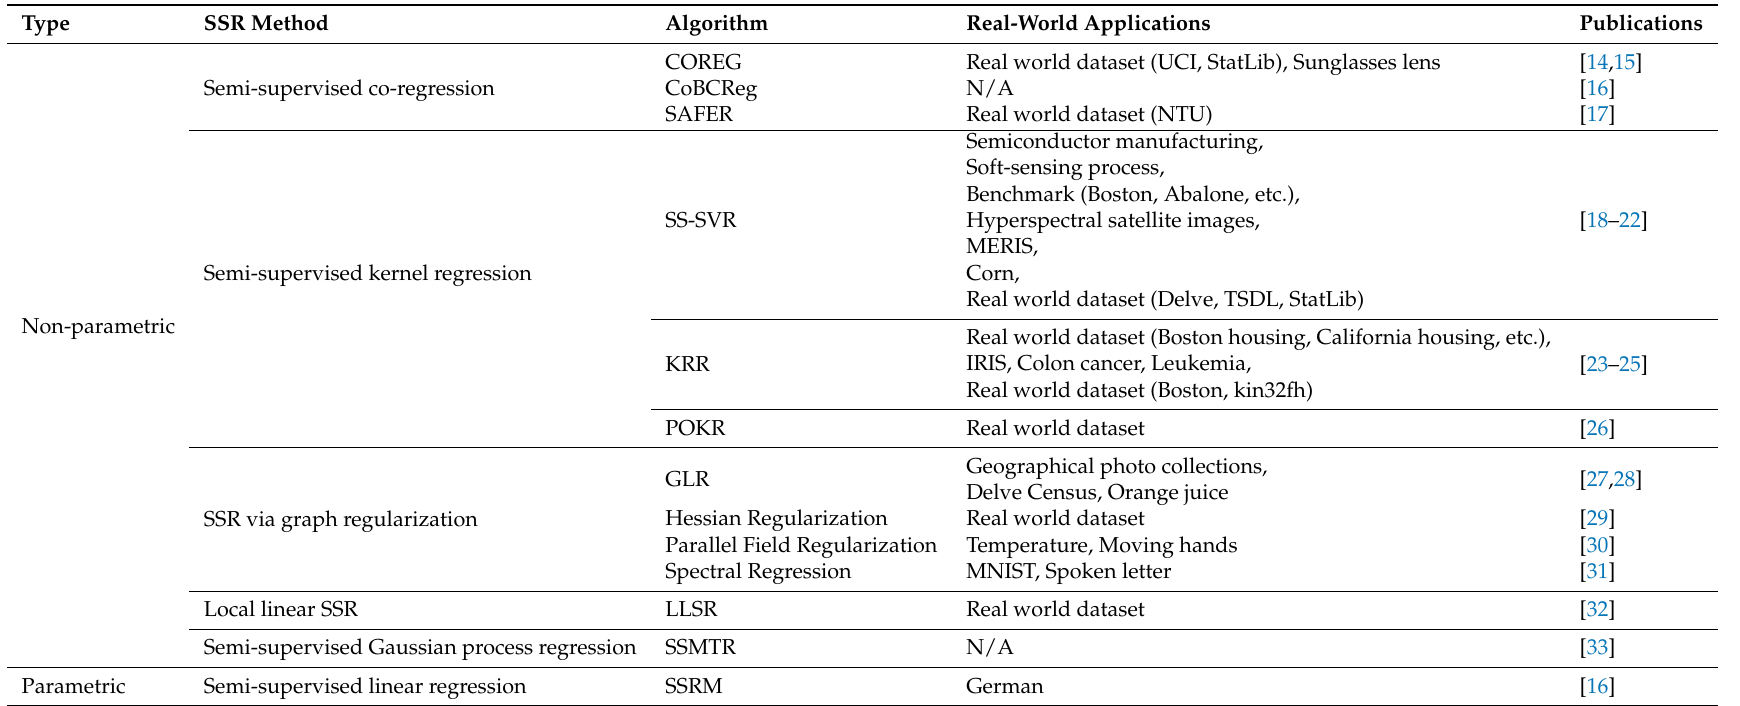
Table 1. Previous studies regarding SSR and its real world